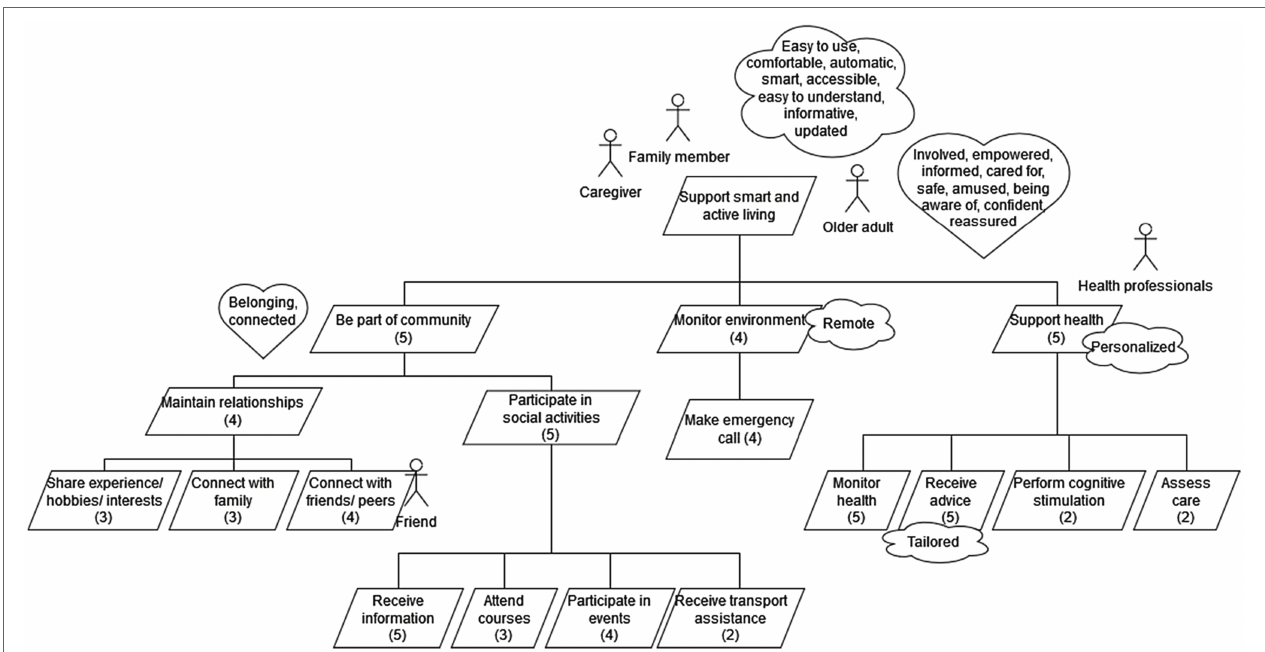
FIGURE 3 | Similar functional, quality, and emotional goals identified. For each functional goal, the number of its occurrence is presented in the